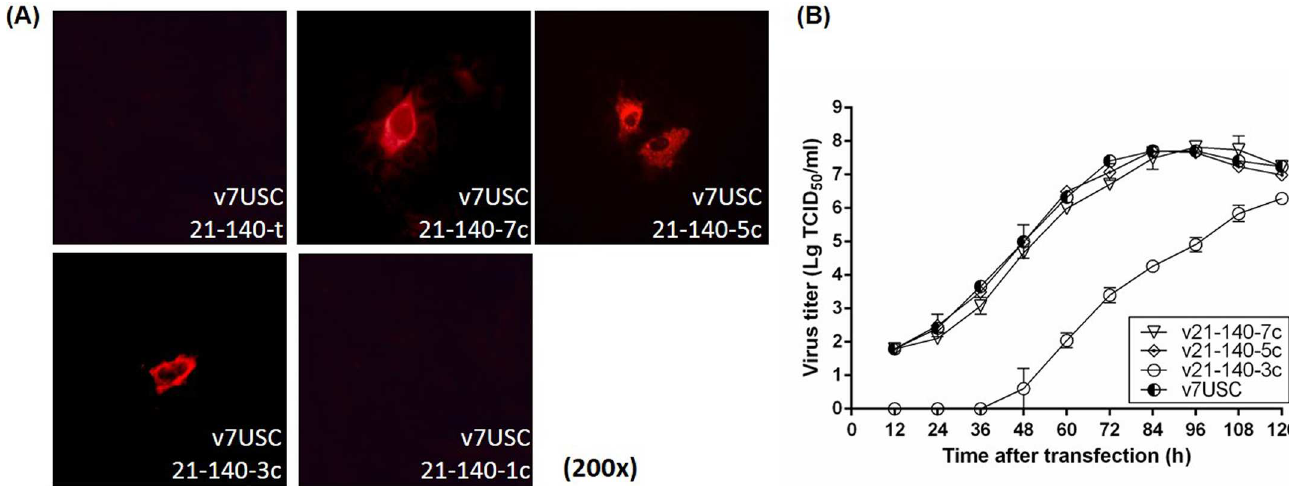
Fig 5. Discontinuous mutations in target sites recovered viral viability and propagation. A: Intracellular viral N-protein expression of high-abundance miRNA- target mutants and control plasmids (p21-140-t, p21-140-7c, p21-140-5c, p21-140-3c, and p21-140-1c). B: Confluent MARC-145 cells were transfected with low- abundant miRNA mutants and control plasmids (p7USC, p505-199-t, and p505-199-c). Supernatants were collected at the indicated times after transfection and titrated for viral-titer determination. Data are shown as the mean ± SD of three independent experiments.